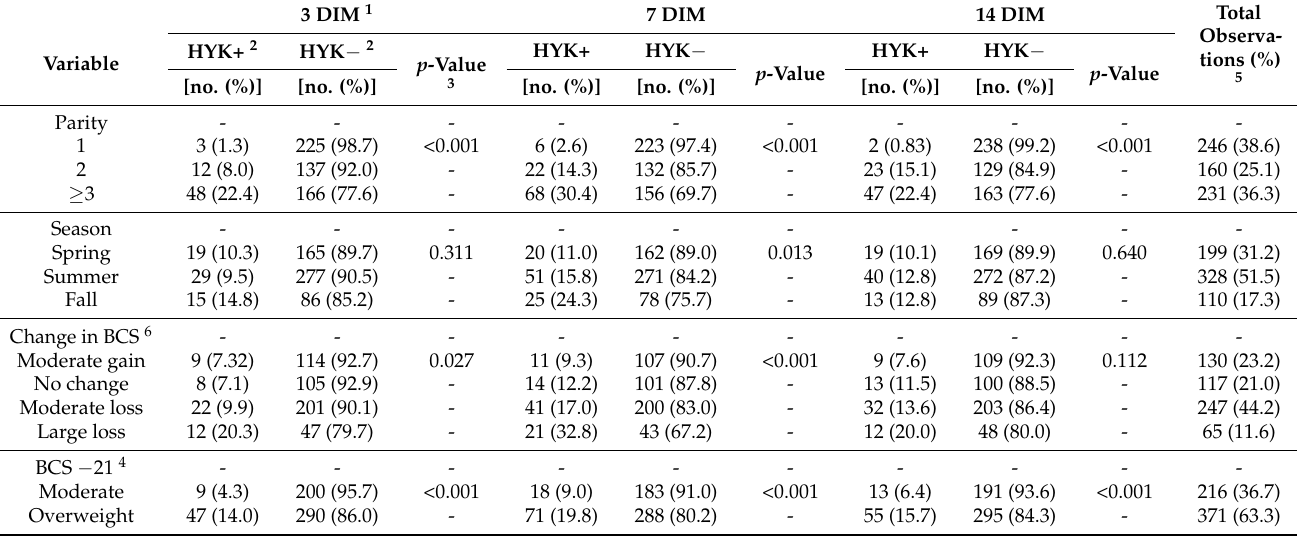
Table 2. Descriptive statistics, sample size, and chi-square test at each sampling time point postpartum.